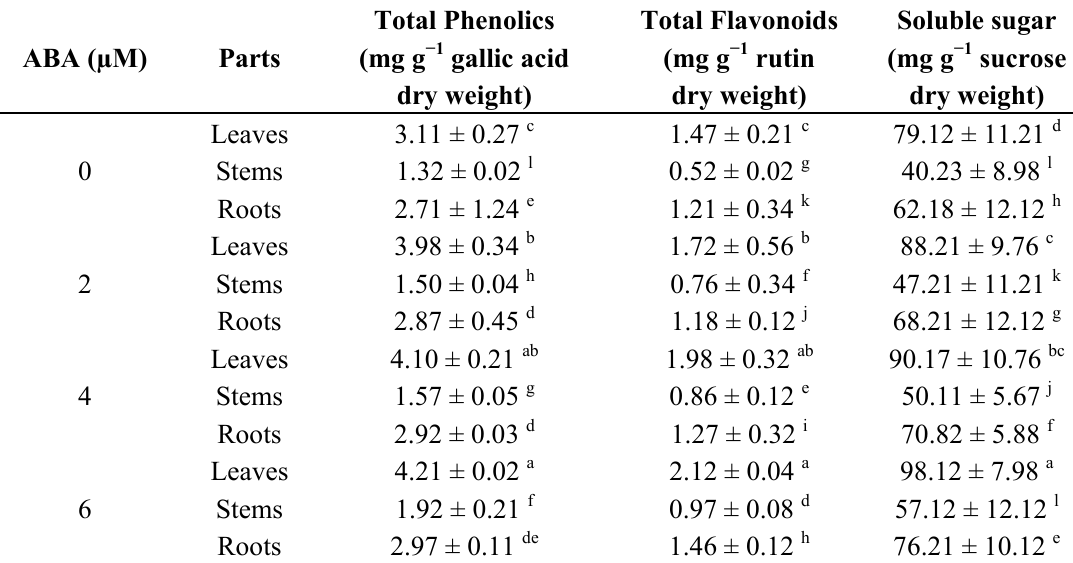
Table 1. Impact of abscisic acid on total phenolics, flavonoids and soluble sugars produced in different parts of Orthosiphon stamineus